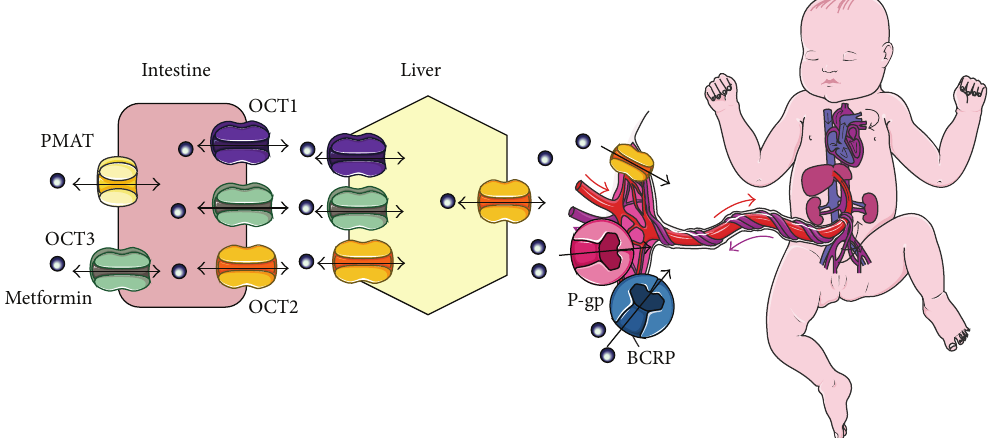
Figure 3: Absorption and distribution of metformin during